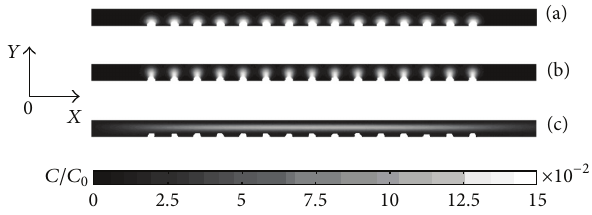
Figure 2: Drug concentration of the artery wall with different models. (a) Isotropic nonporous medium, (b) isotropic porous media, and (c) anisotropic porous media.